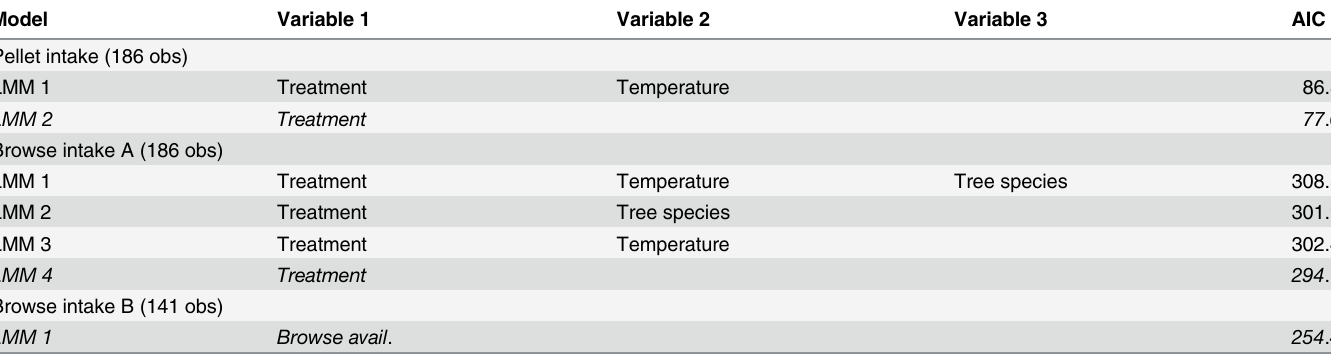
Table 3. Alternative linear mixed models (LMM) that test which variables influenced the moose ’ intake of pellets and browse.